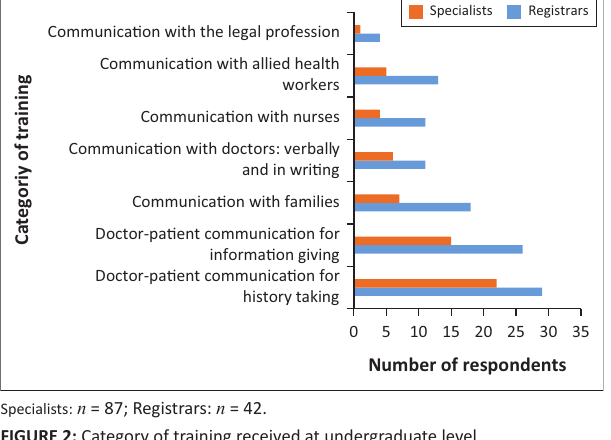
FIGURE 2: Category of training received at undergraduate level. TABLE 2: Opinions relating to interpersonal communication training.